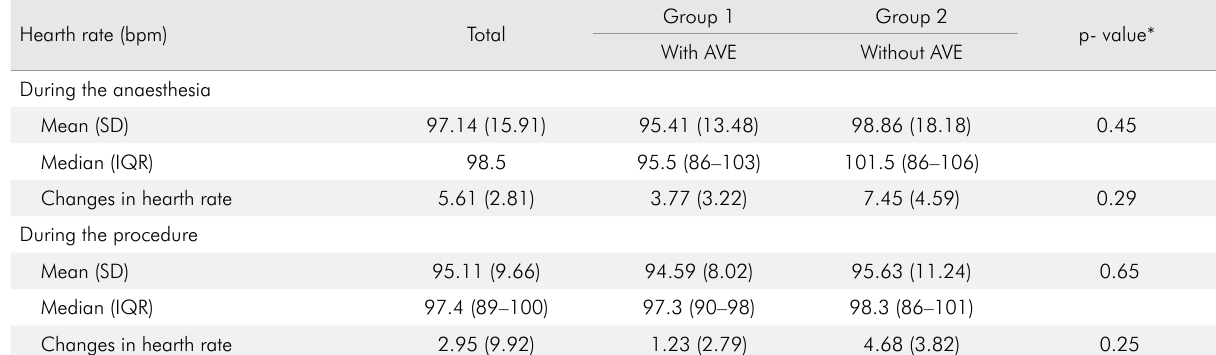
Table 3. Mean, median and interquartile range (IQR) heart rate during the local anaesthesia and during the dental visit according to the use of audiovisual eyeglasses (AVE) (n = 44).